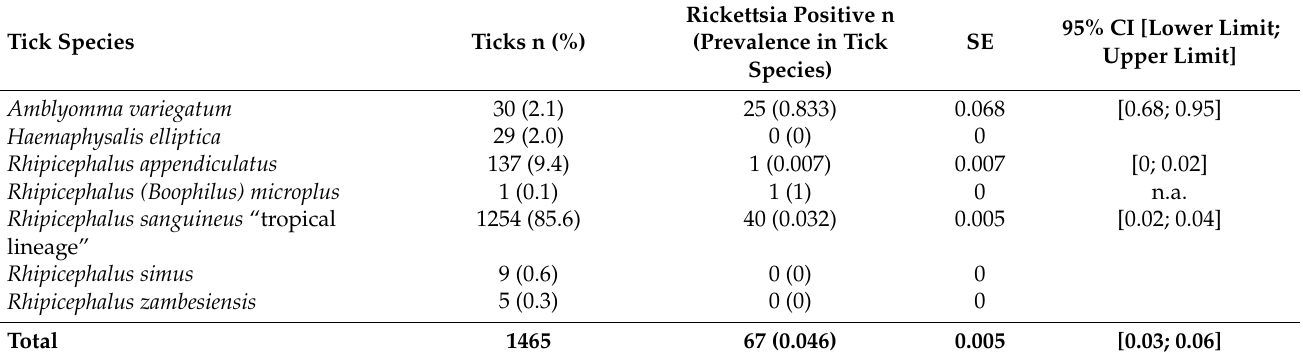
Table 2. Total number of different tick species and Rickettsia positive specimens per tick